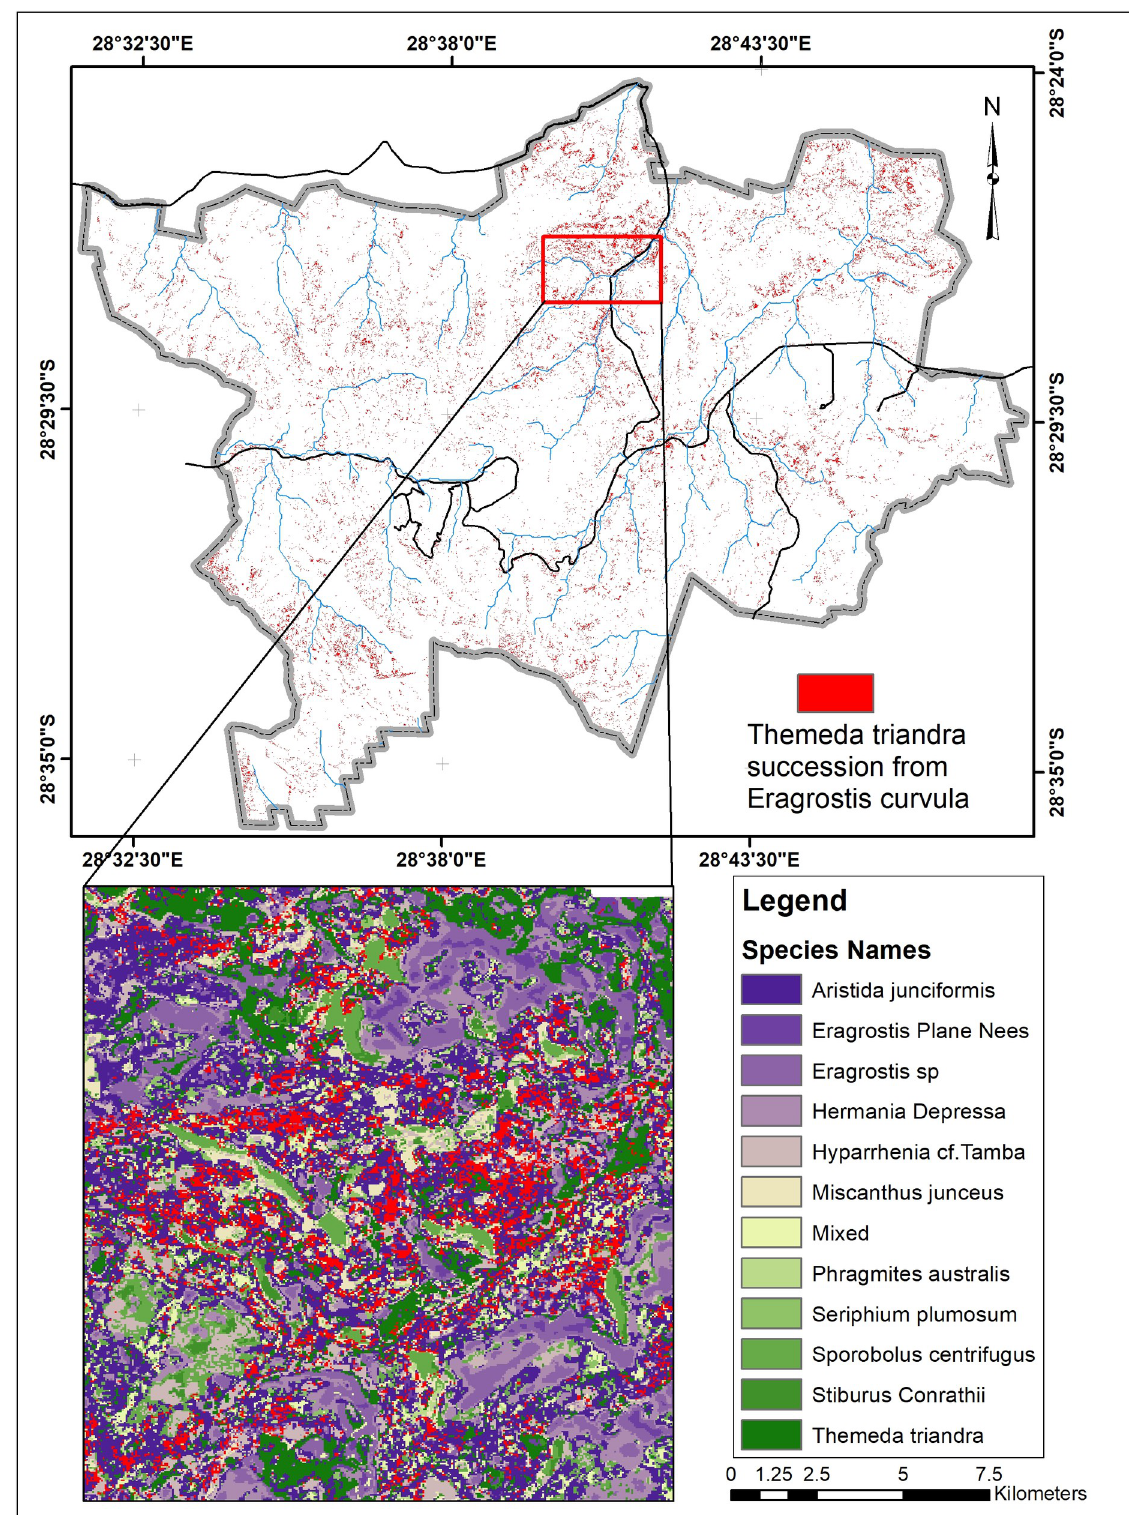
Fig 6. Areas where Themeda triandra succeeded from Eragrostis curvula